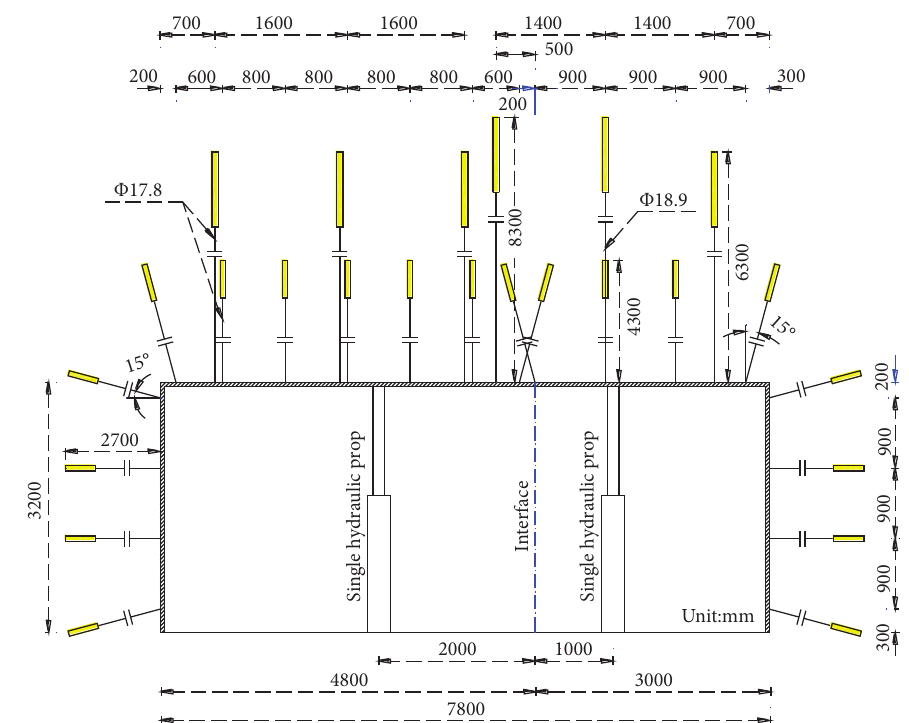
Figure 13: Parameter diagram of the LODM support in 5202 working face.